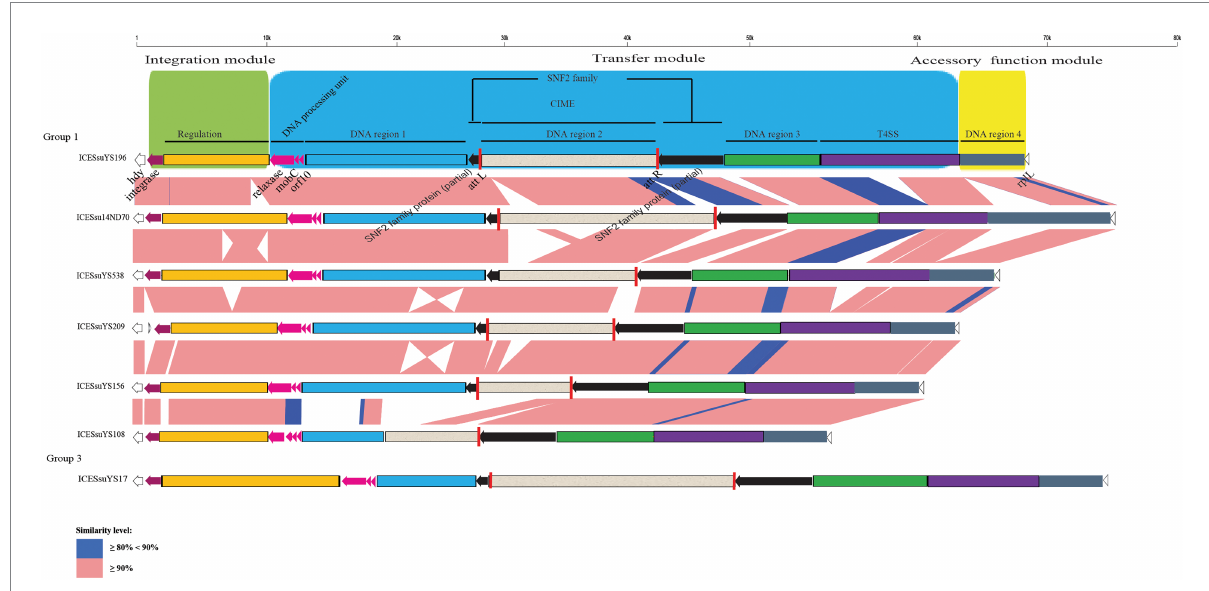
FIGURE 2 Schematic comparison of representative ICEs carrying CIMEs. The direction of the arrow indicates the direction of transcription. Regions of >90 and 80- 90% identity are marked by pink and blue shading, respectively. The DNA regions, T4SS, CIMEs, integrase gene, relaxase gene, mobC , orf10 , snf2 gene, att site, integration module, transfer module, and accessory module of ICEs are indicated by different colors. The rplL and hdy genes are located in the flanking region of the